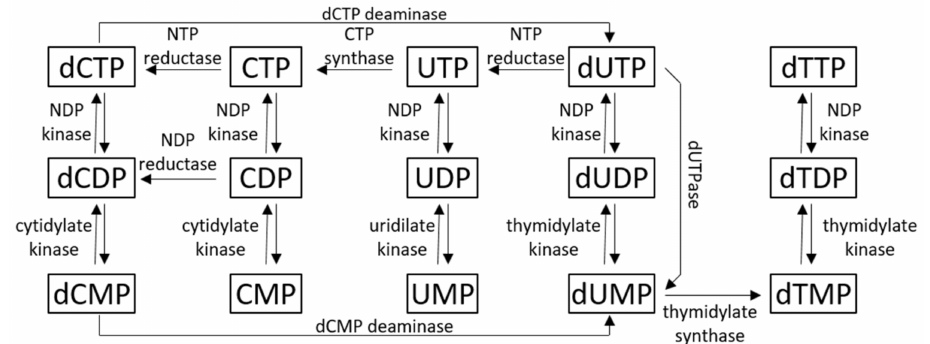
Figure 1. Pyrimidine nucleotide metabolism.